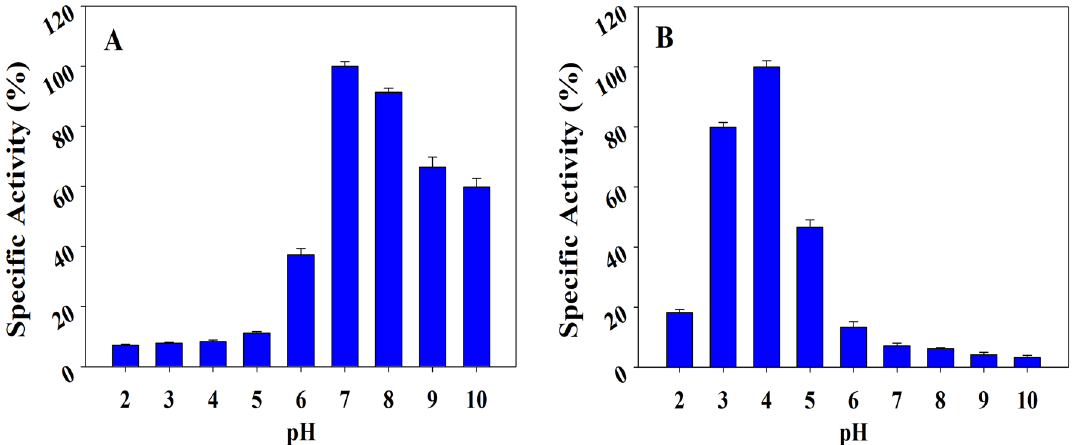
Figure 5. Effect of pH (2.0–10.0) on hPrdx6’s glutathione peroxidase and aiPLA 2 activity. ( A ) Plot of specific glutathione peroxidase activity (%) versus pH. The percent specific activity of the enzyme at pH 7.0 is considered as 100%, and ( B ) Plot of specific calcium independent phospholipase A2 activity (%) versus pH. The percent specific activity of the enzyme at pH 4.0 is considered as